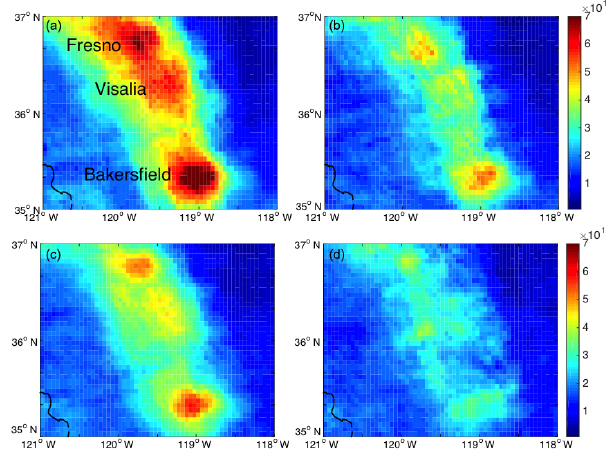
Figure 1. Wintertime (November–March) NO 2 columns (moleculescm − 2 ) in the SJV using the UC Berkeley OMI BEHR retrieval (Russell et al., 2011). The urban NO 2 plumes of Fresno, Visalia, and Bakersfield are labeled to the left of their respective cities in panel (a) . Panel (a) shows 2005–2006 weekdays (Tuesday–Friday). Panel (b) shows 2005–2006 week- ends (Saturday–Sunday). Panel (c) shows 2012–2013 weekdays. Panel (d) shows 2012–2013